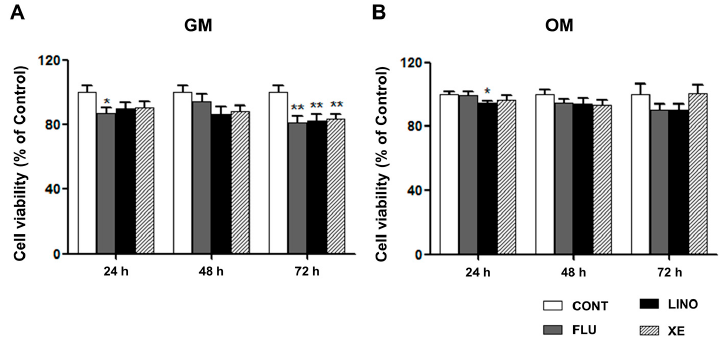
Figure 5. Effect of flupirtine, linopirdine, and XE991 on MG-63 cell viability. The MTT assay was performed on MG-63 cells. ( A ) MG-63 cells were incubated in growth medium (GM) with 30 μ M of flupirtine, 30 μ M of linopirdine, and 10 μ M of XE991. At 72 h, linopirdine, XE991, and flupirtine caused notable decreases in cell viability ( n = 16); ( B ) MG-63 cells were cultured in osteoblast-induction medium (OM) with 30 μ M of flupirtine, 30 μ M of linopirdine, and 10 μ M of XE991. The cell viability was not significantly influenced by OM containing linopirdine, XE991, or flupirtine for 72 h of treatment ( n = 16). The values are presented as mean ± SEM. * p < 0.05 and ** p < 0.01. CONT: non-treated controls; FLU: flupirtine; LINO: linopirdine; XE: XE991.